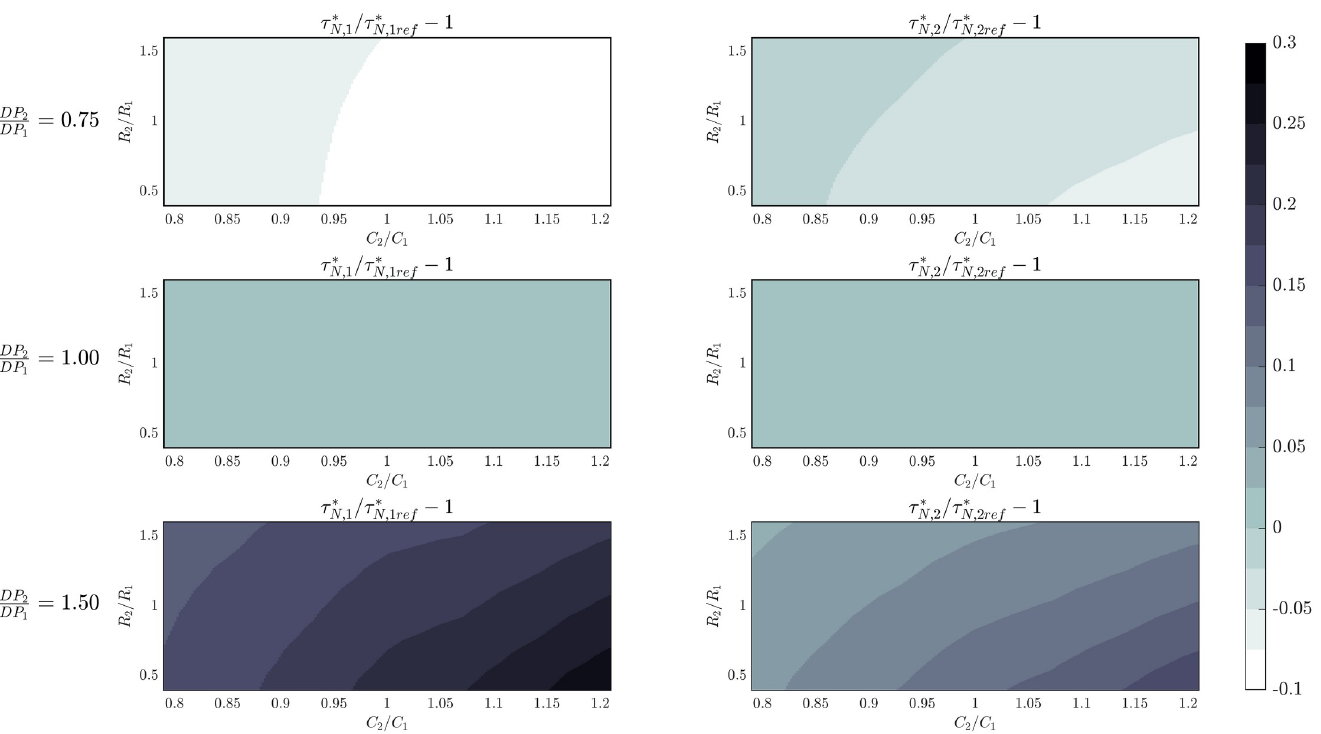
Fig 11. Incidence on exhalation characteristic times of asymmetries between patients.